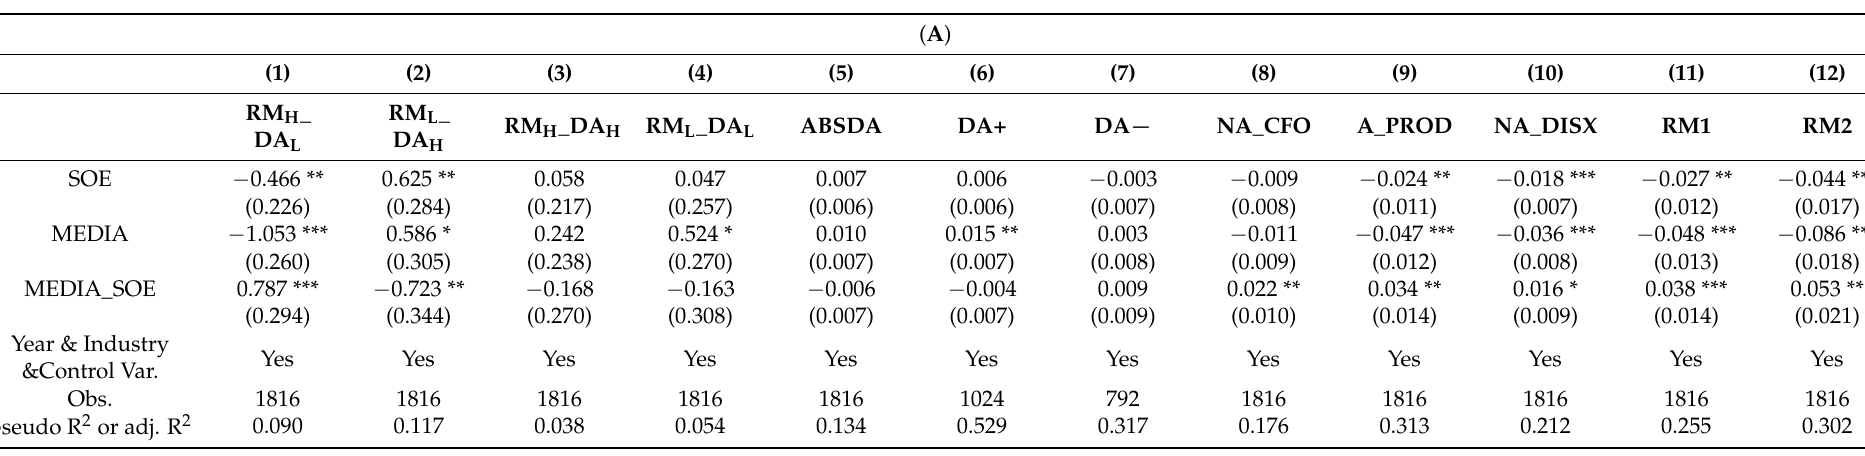
Table 10. The Joint Effects of State Ownership and Media Attention on Earnings Management. Panel ( A ) Regressions on SOEs, Panel ( B ) Regressions on CSOEs and